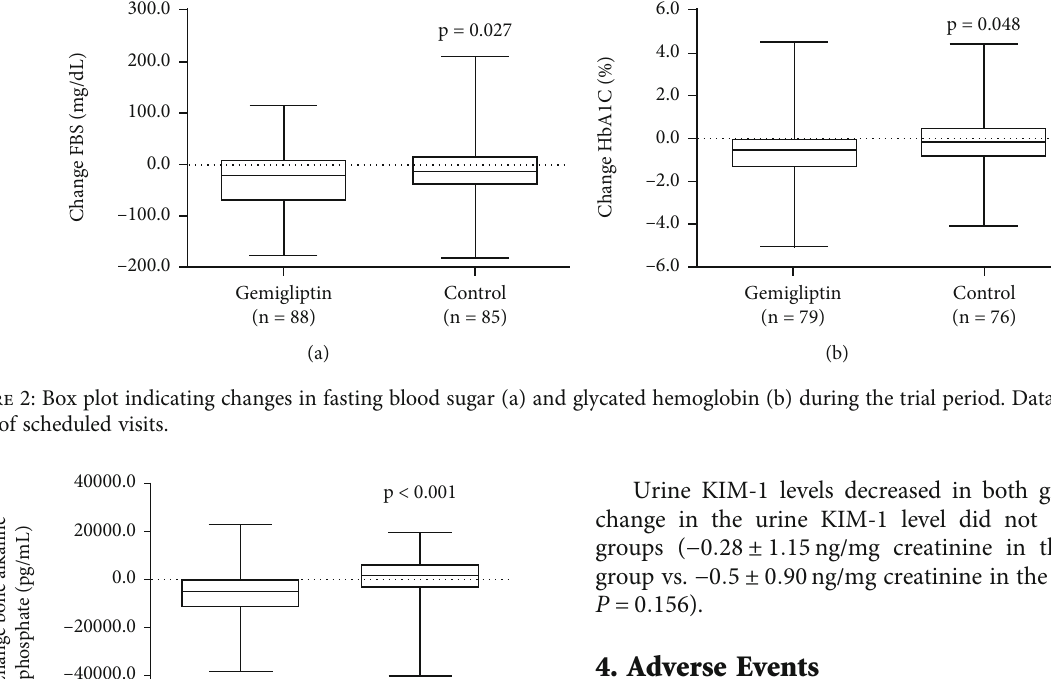
gemigliptin group vs. 257 : 28 ± 1047 : 29 ng/mg creatinine in